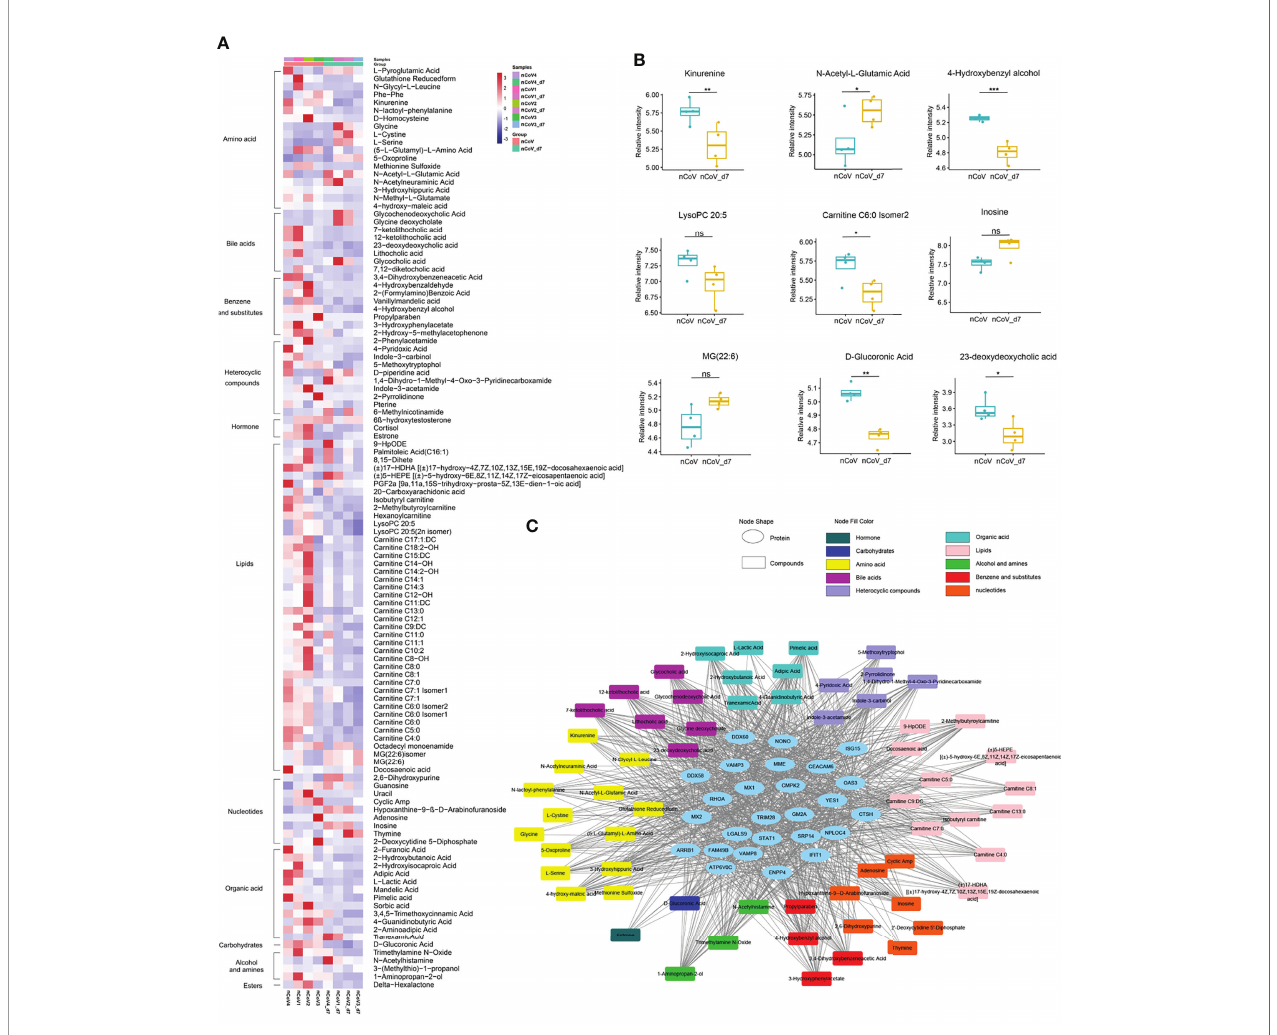
FIGURE 7 | Dysregulated metabolites in sera of CMs inoculated with SARS-CoV-2, and statistics of functional and pathway enrichment. (A) Heatmap of 116 most signi fi cantly regulated metabolites belonging to 11 major classes as indicated. (B) The expression level change of nine selected regulated metabolites with signi fi cant difference before and after inoculated with SARS-CoV-2. (C) Scatter plot of KEGG enrichment analysis between nCoV vs. nCoV-d7 with signi fi cant changes. CMs, cynomolgus macaque; nCoV, SARS-CoV-2; nCoV_7d, 7 days post SARS-CoV-2 infection; KEGG, Kyoto encyclopedia of genes and genomes. *p<0.05; **p<0.01; ***p<0.005. ns, not signi fi